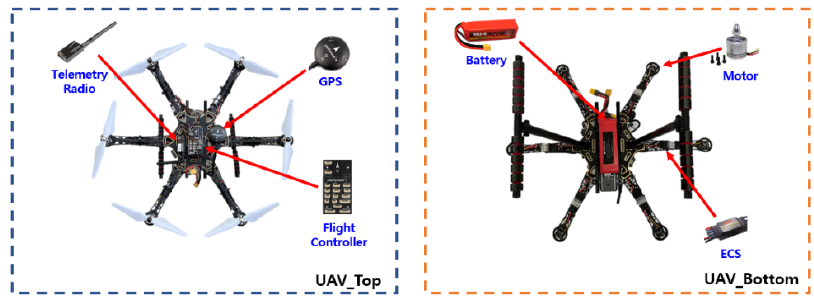
Figure 1. Main components of the collaborative unmanned aerial vehicle.